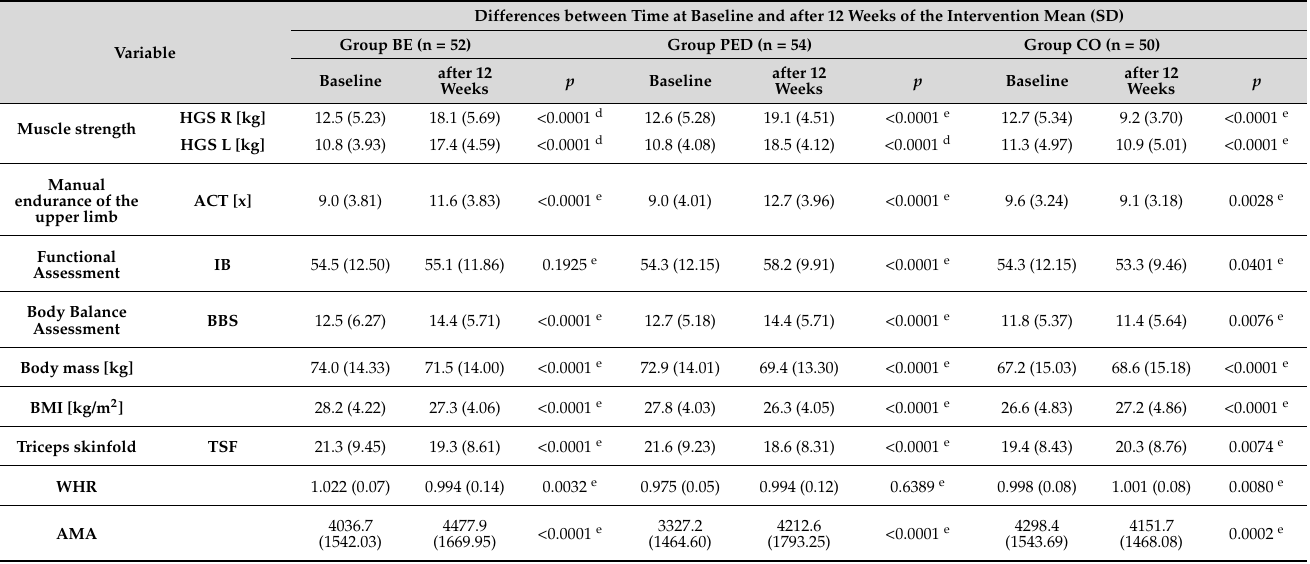
Table 2 description: A statistical model was adopted in which the effect of intervention between Measure I and Measure II was tested. For the normality of the distributions of differences (tested by the Shapiro–Wilk test), the Student’s t -test for dependent samples was used. If the assumption of the normality of the distribution of differences was violated, the non-parametric Wilcoxon test was used. Table 2. Results of the effects in the study groups between the baseline and the 12-week timepoint. Differences between Time at Baseline and after 12 Weeks of the Intervention Mean (SD) Group BE (n =